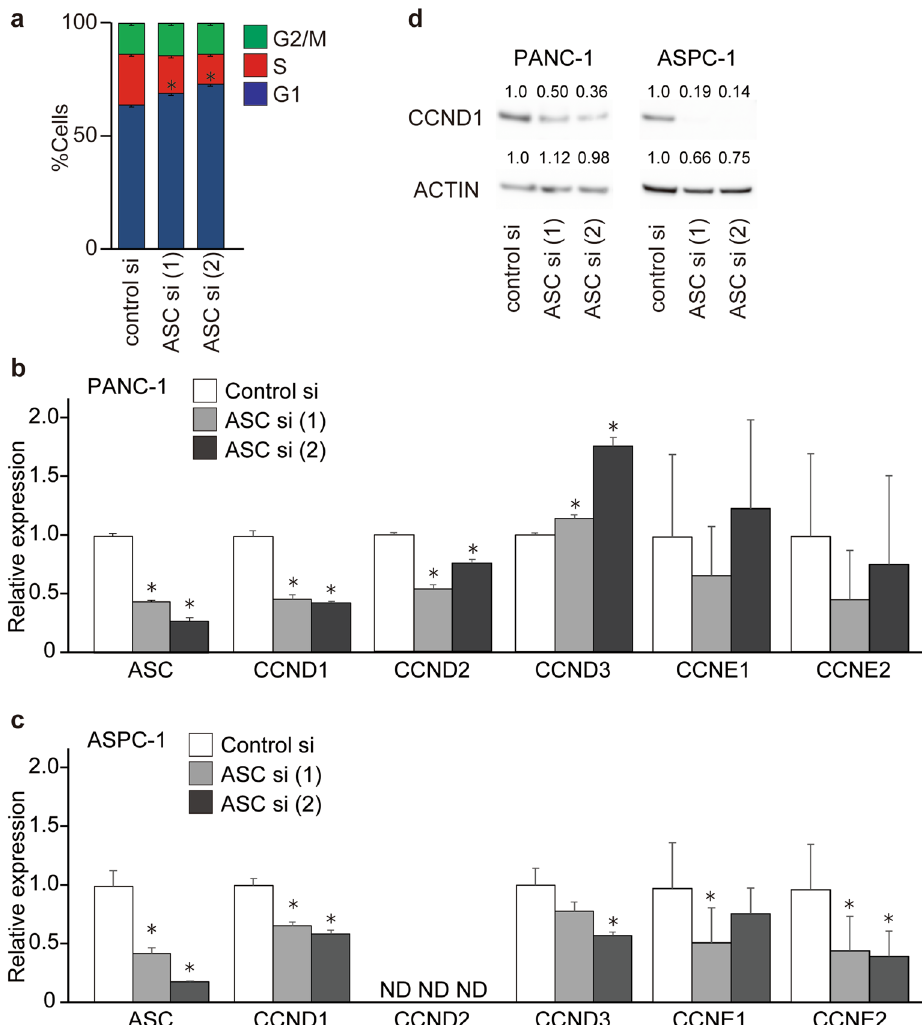
Figure 6. ASC silencing reduces CCND1 expression and blocks the cell cycle at the G1 phase. ( a ) Quantification of three experimental replicates of cell cycle phase distribution. Error bars indicate the standard error of the mean based on three independent experiments. *p < 0.05 vs. control, Student’s t test. ( b , c ) mRNA levels of CCND s and CCNEs according to real-time RT-PCR following ASC silencing in PANC-1 and ASPC-1 cells. Data represent the mean ± standard error of the mean of three to four replicates. ( d ) CCND1 expression following ASC silencing according to western blot. Relative densitometry data as compared with controls are given for each lane. The original gel images of Western blotting are shown in Fig.